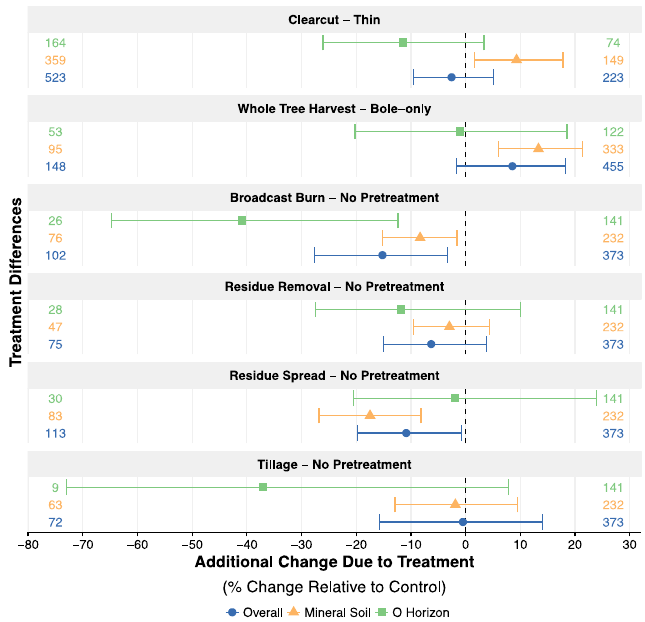
Figure 4. Differences in response of soil C to harvesting between treatment strategies. Differences are calculated by subtracting [more intensive treatment] − [less intensive treatment], such that positive differences represent reduced loss of C due to more intensive treatment, and negative differences represent increased losses of C due to more intensive treatment. Point estimates are back-transformed differences between mean effect sizes ± 95% confidence intervals calculated by nonparametric bootstrap. Mean effect differences with confidence intervals overlapping the dashed line (0%) show no significant difference between the harvesting, residual management, or pretreatment strategies. The number of response ratios ( k ) for the intensive treatment in each comparison appear on the left and for the less intensive treatment on the right.